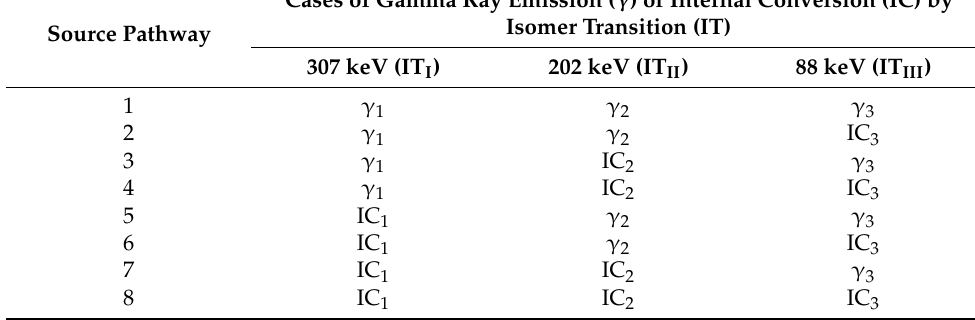
Table 1. The source pathway by combinations of the isomer transition pathway.